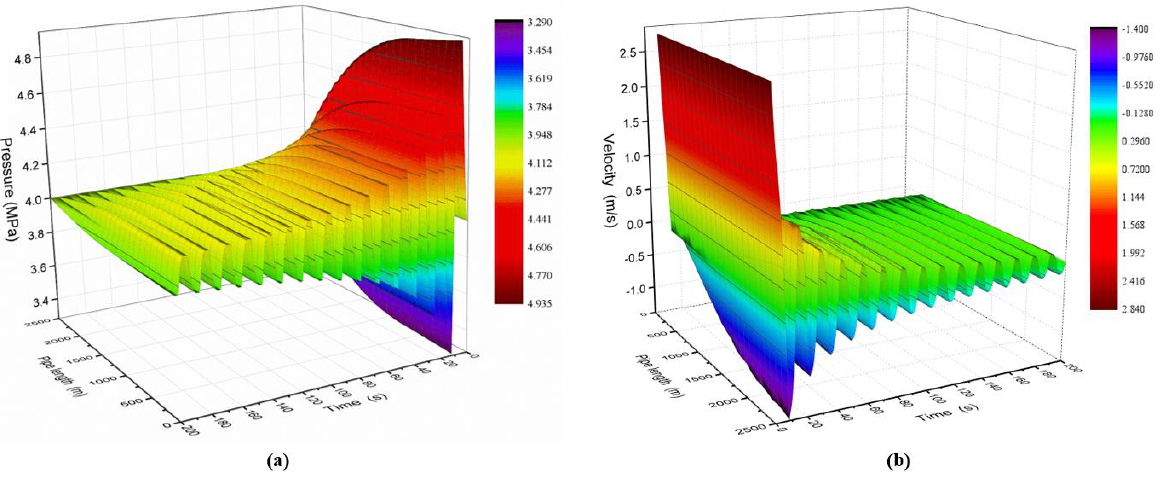
Figure 10. Three-dimensional diagram of pressure-wave propagation with pipe length and time after valve closing: ( a ) represents pressure response; ( b ) represents velocity